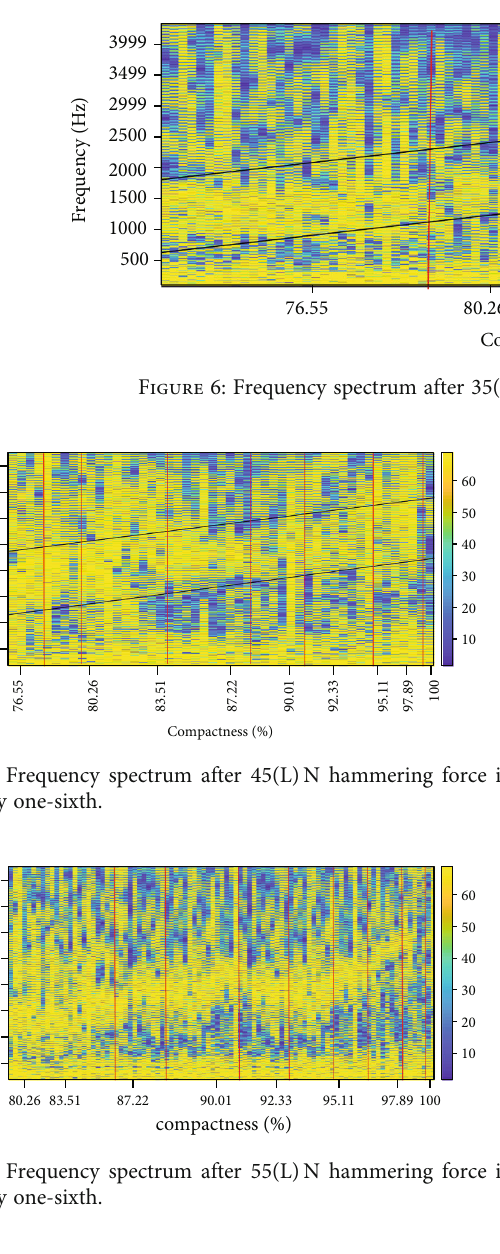
Figure 5: Spectrogram of soil samples with di ff erent compaction of soil samples after frequency reduction by one-sixth.